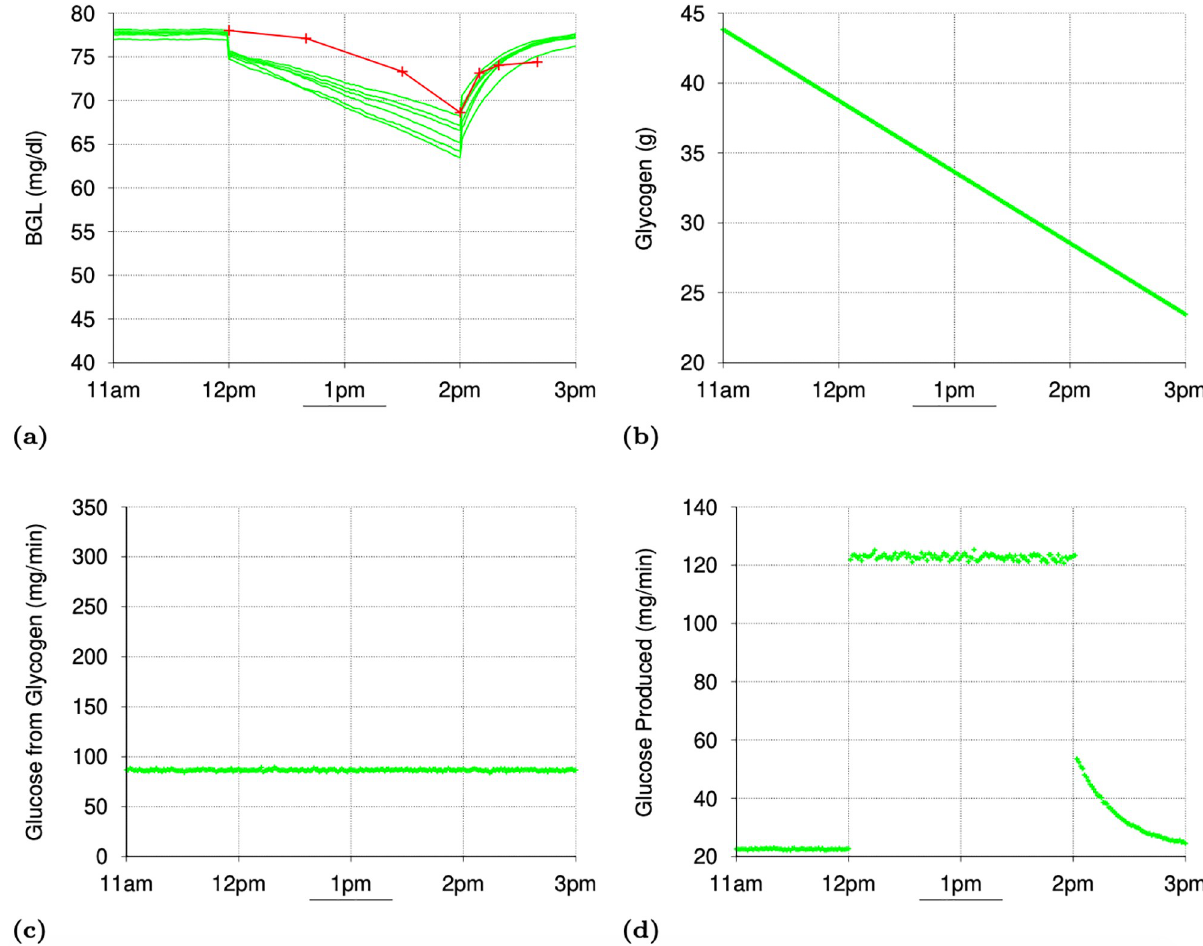
Fig 5. Results of simulations replicating a physical exercise event involving legs at intensity 30% VO 2 max as reported in [80]. (a): Green: BGL for 6 simulated subjects; Red: average BGL reported in [80]. (b): Liver glycogen for the subject # 1. (c): Liver glycogen breakdown for the subject # 1. (d): Total gluconeogenesis in Liver and Kidneys for the subject #